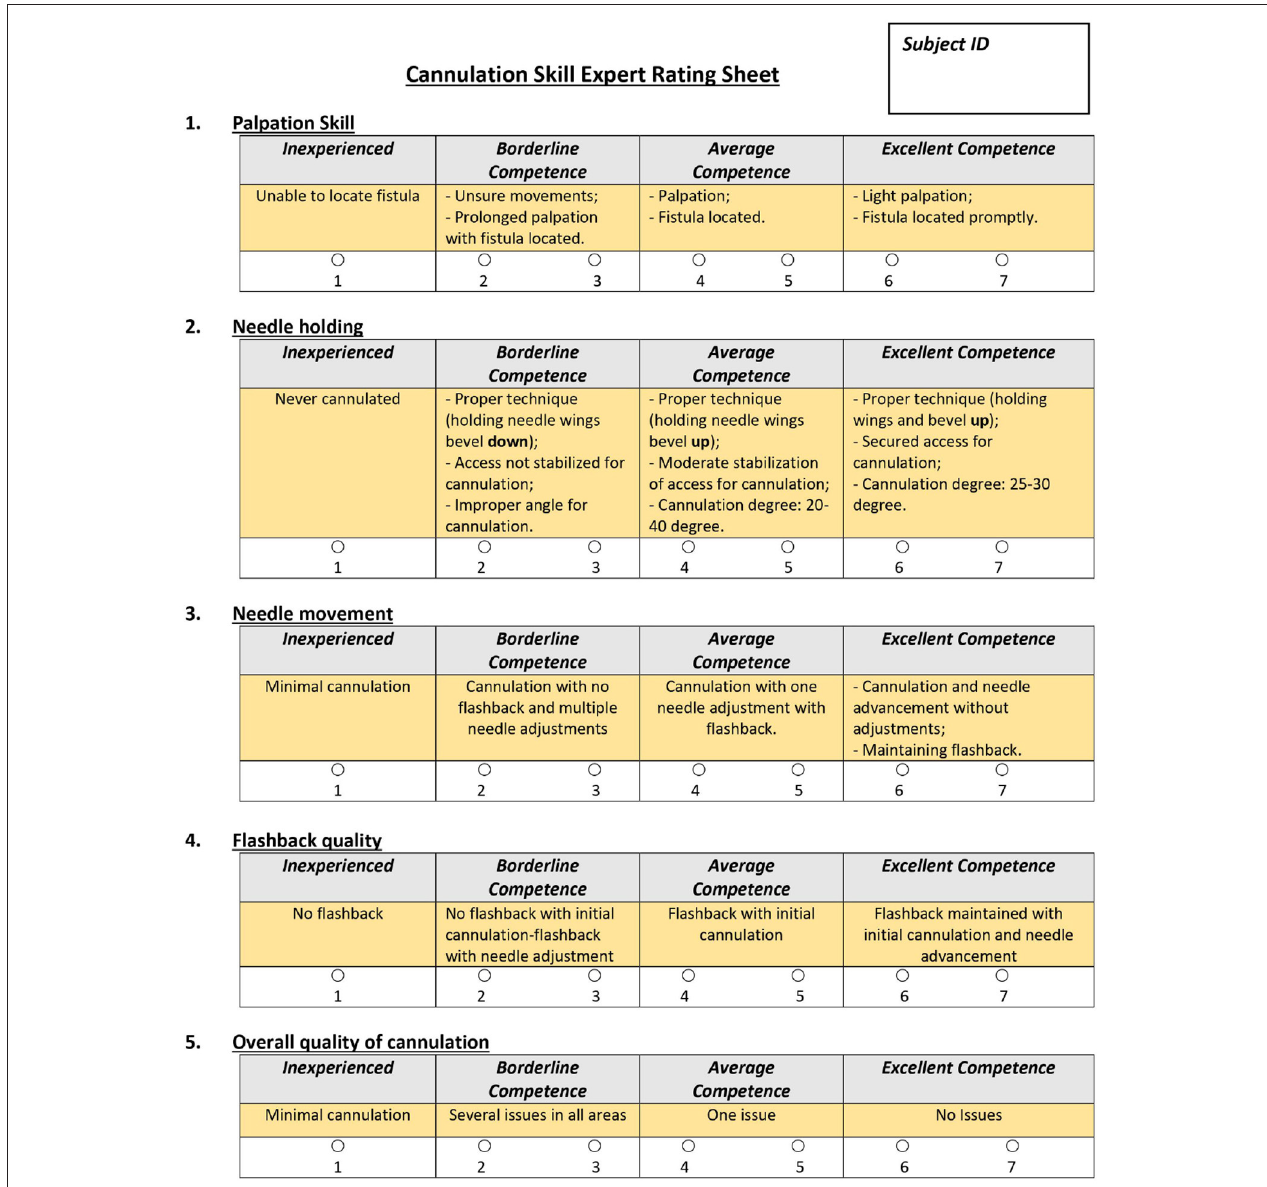
FIGURE 4 | GRS Rating